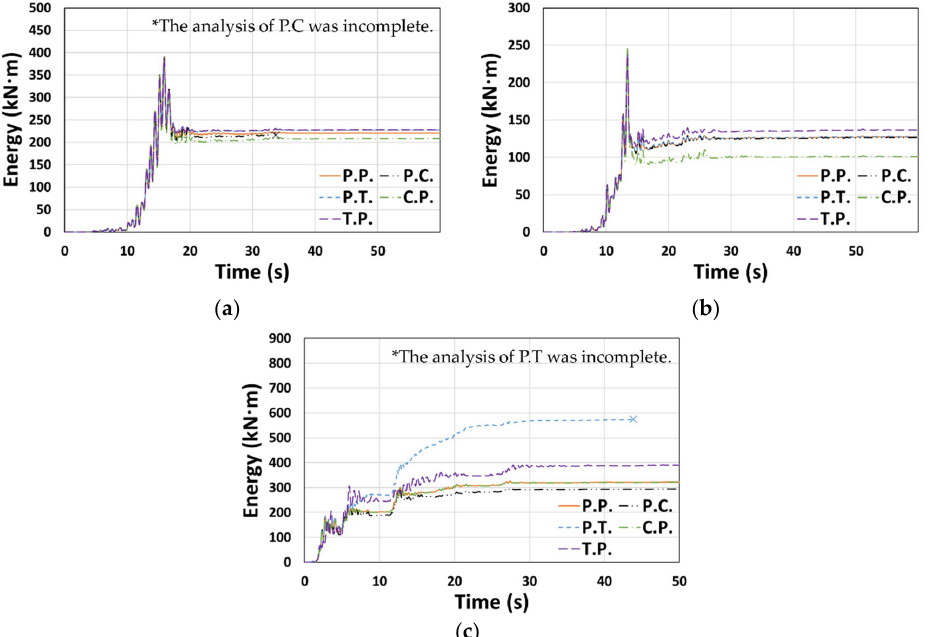
Figure 9. Cumulative dissipated energy: ( a ) Type 3 (Northridge, X-dir.), ( b ) Type 3 (Northridge, Y-dir.), and ( c ) Type 2 (El Centro, X-dir.).